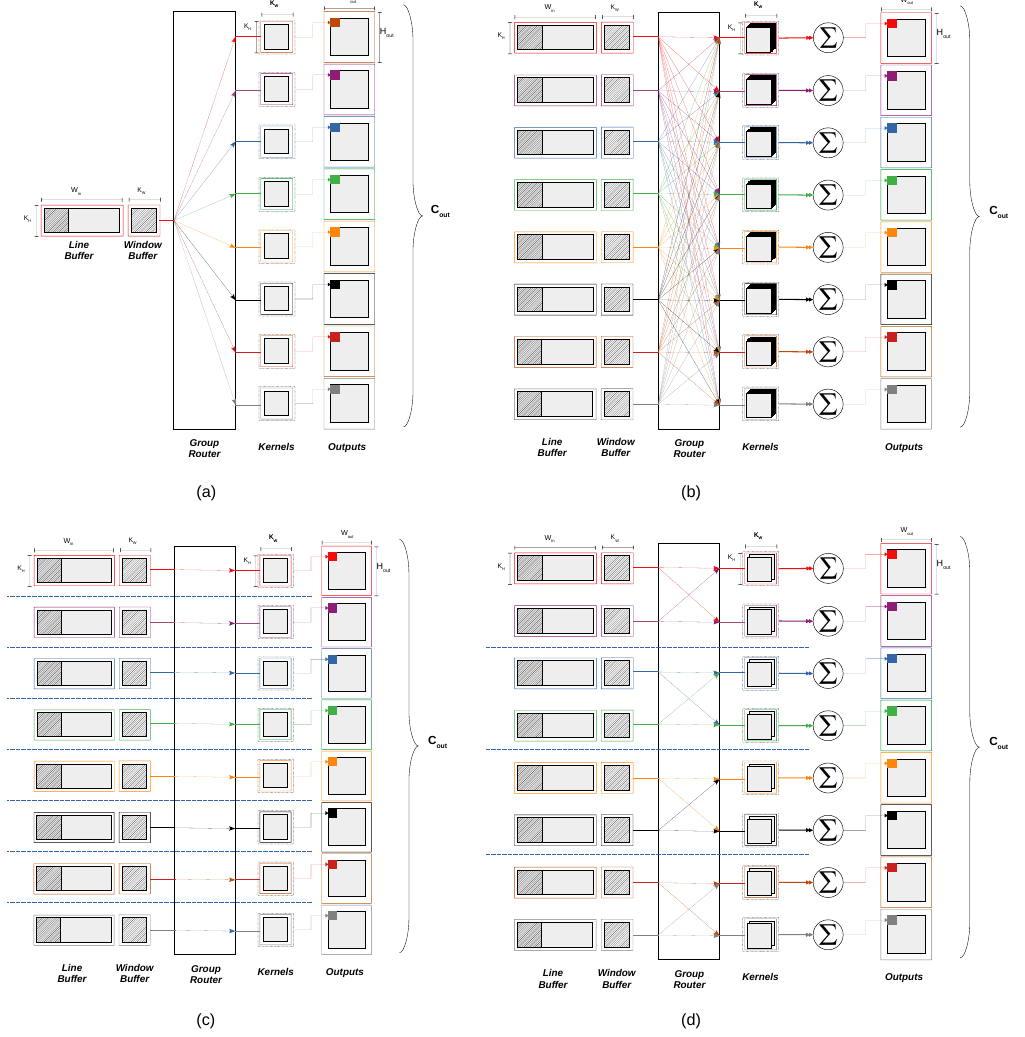
Figure A1. Group Convolution for 8 output feature maps. This figure shows 4 different examples to obtain 8 output feature maps. ( a ) The 2D convolution for a single input feature map. In this case, the input consists of a single group and 8 kernels. Each kernel is convoluted with the input feature map to produce an output feature map. ( b ) The case of 8 input feature maps and a single input group, where 64 kernels are split into 8 groups and each group is convoluted with the input. The summation is necessary to obtain the desired number of output feature maps. ( c ) Depthwise convolution. The input is split into 8 groups and each output feature map is computed depending form a single input feature map. ( d ) Another example of group convolution in which the input is split into 4 groups. In this case, a total number of 16 kernels are required and each input group is convoluted with a set of 4 kernels. We ignored the summation in ( a , c ) since the result of each convolution is a single output feature